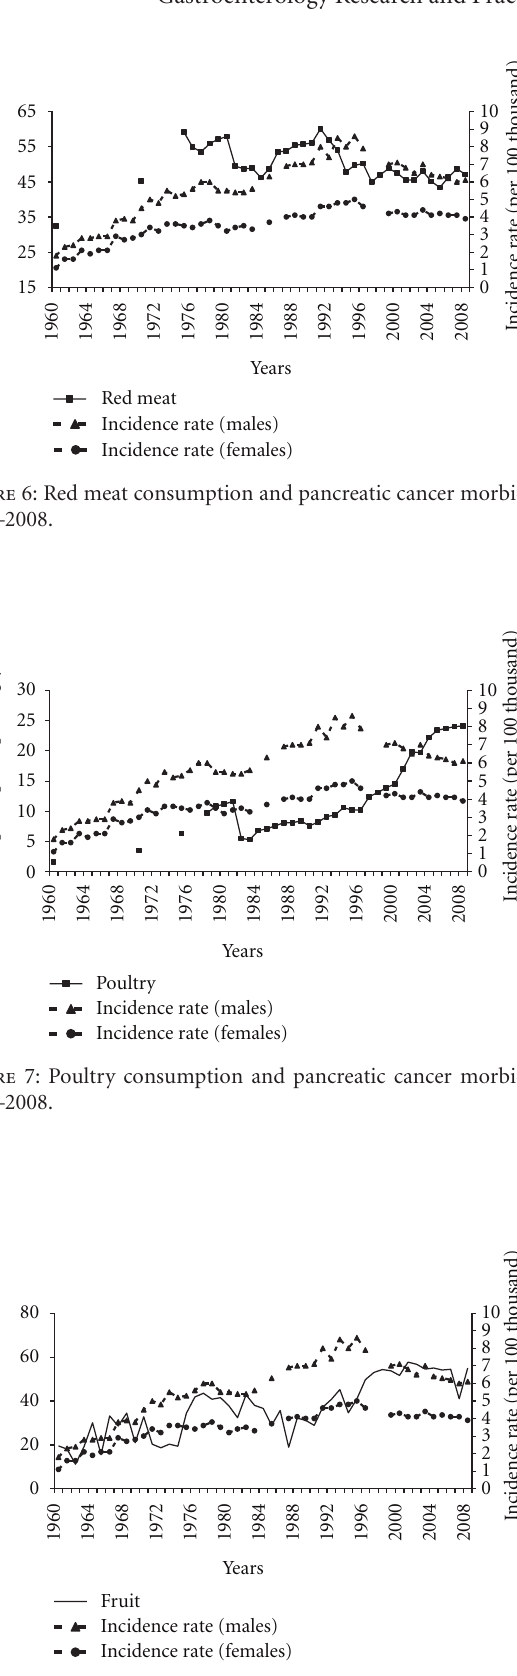
Figure 8: Fruit consumption and pancreatic cancer morbidity